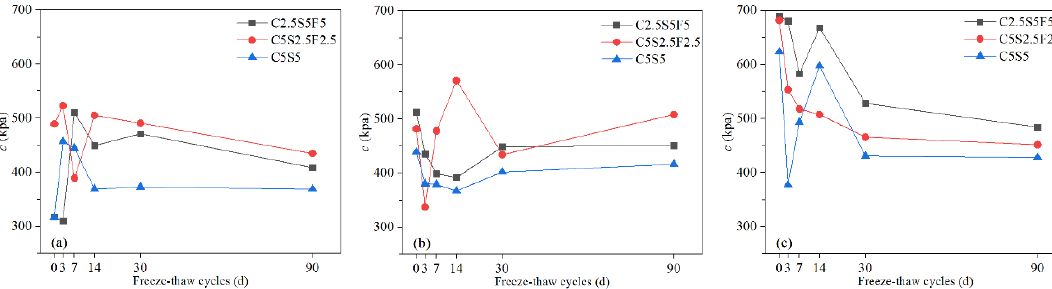
Figure 11. The c of Pb-CSCSs with the same contaminant content but different compound binders: ( a ) 0.05% Pb 2+ ; ( b ) 0.5% Pb 2+ , and ( c ) 1% Pb 2+ .